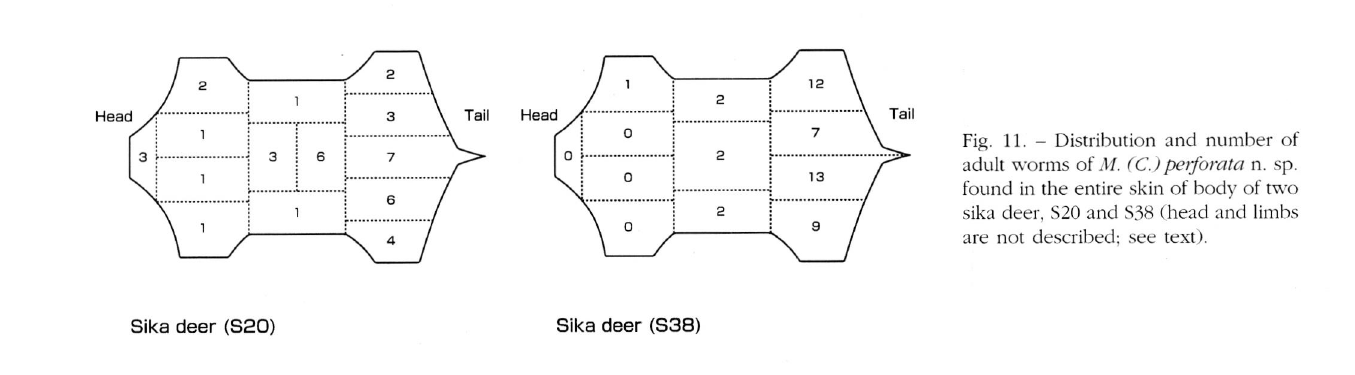
Fig. 11. - Distribution and number of adult worms of M.(C.) perforata n. sp. found in the entire skin of body of two sika deer, S20 and S38 (head and limbs are not described; see